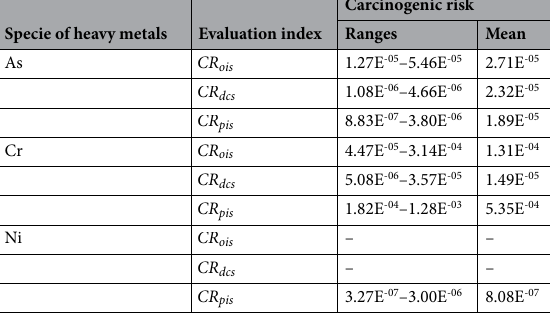
Table 6. Carcinogenic risk evaluation of heavy metals in